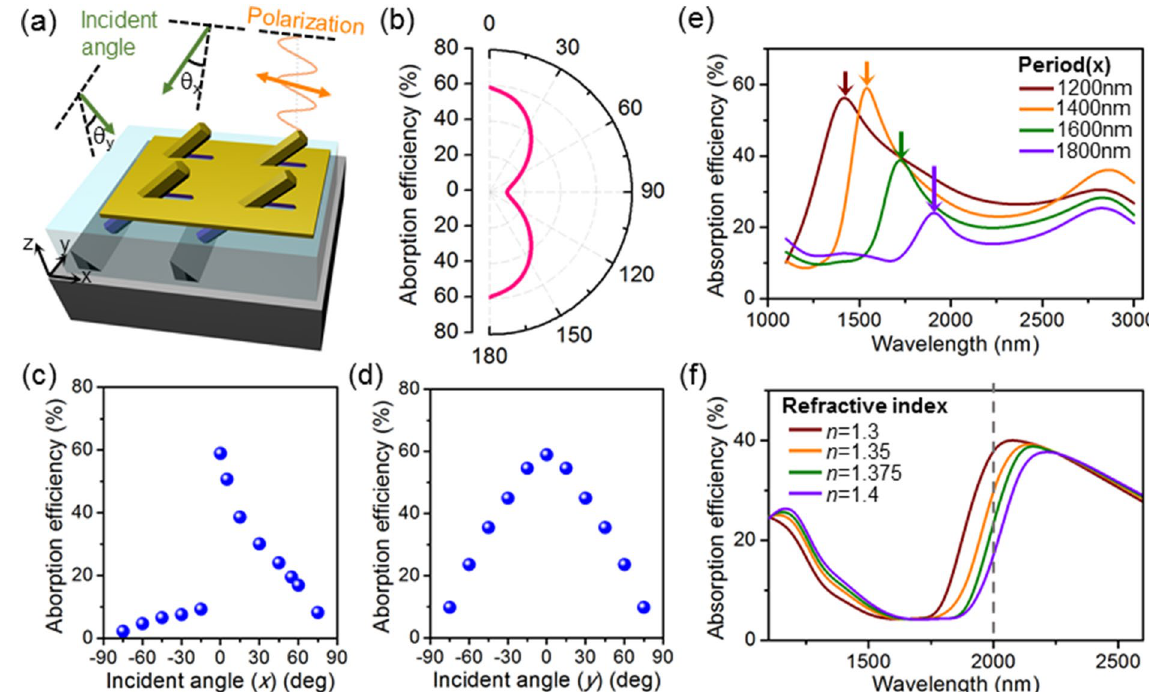
Figure 4. Sensitivity of the meta-absorber. ( a ) Schematic of the polarization and angle of light incident upon the meta-absorber. ( b ) Effect of polarization on the absorption efficiency. 0° represents x -polarization. ( c ) Change of absorption efficiency by tilting the incident light along the x -axis and ( d ) y -axis. ( e ) Broadband absorption spectra of the structure as a function of periodicity, showing the shift of peak wavelength